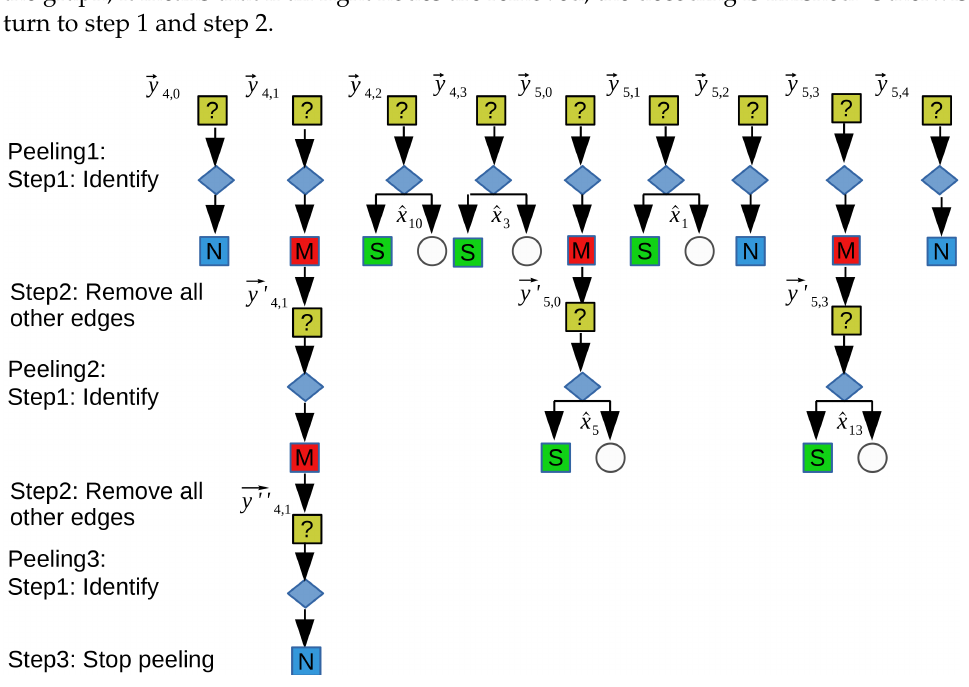
Figure 4. Example of the process of the genie-assisted peeling decoder. In the first peeling, three “zero-ton”, three “single-ton”, and three “multi-ton” are distinguished. In the second peeling, two “single-ton” and one ”multi-ton” are distinguished. In the third peeling, one “zero-ton” is